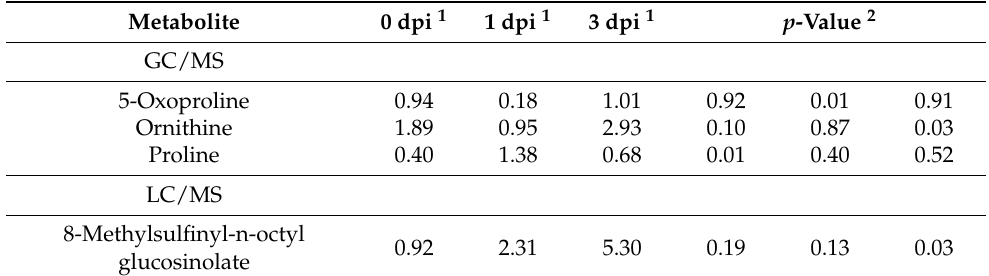
Table 2. Ratio of primary and secondary metabolites accumulation ( NFS1.2-18-OX / WT) upon P. syringae pv. tomato DC3000